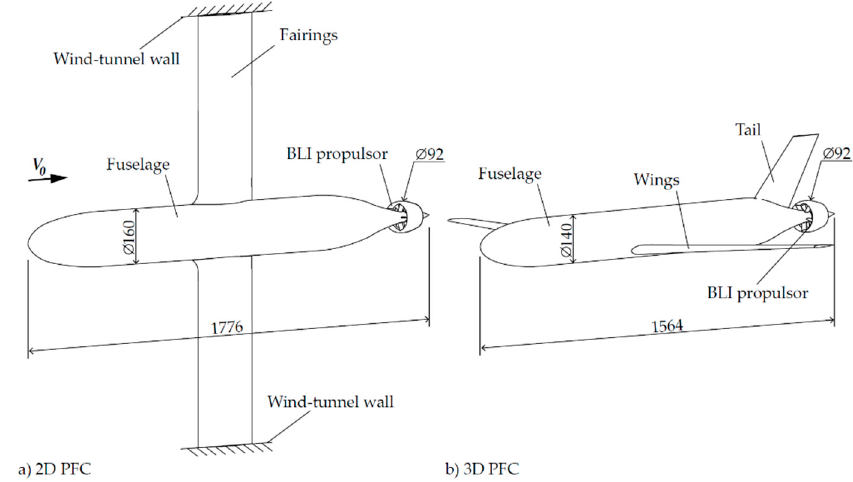
Figure 14. Schematics of the wind-tunnel models setup. Dimensions in mm.